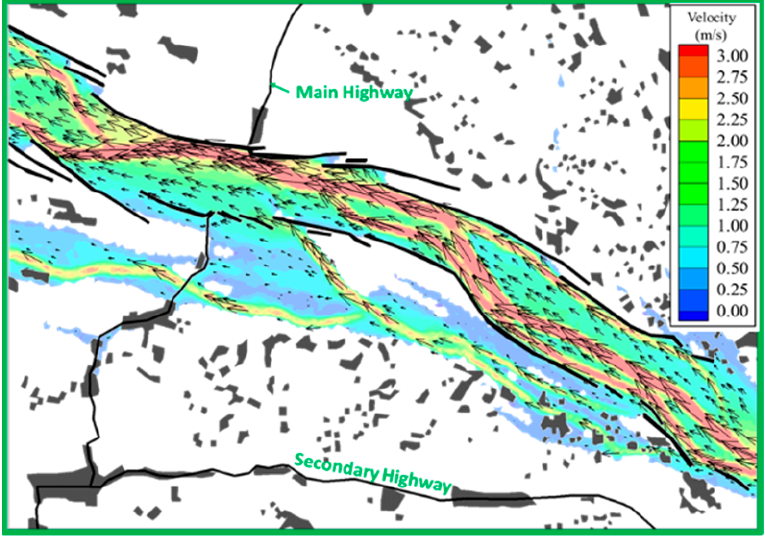
Figure 13. Overflow and return flow through levee openings (Case